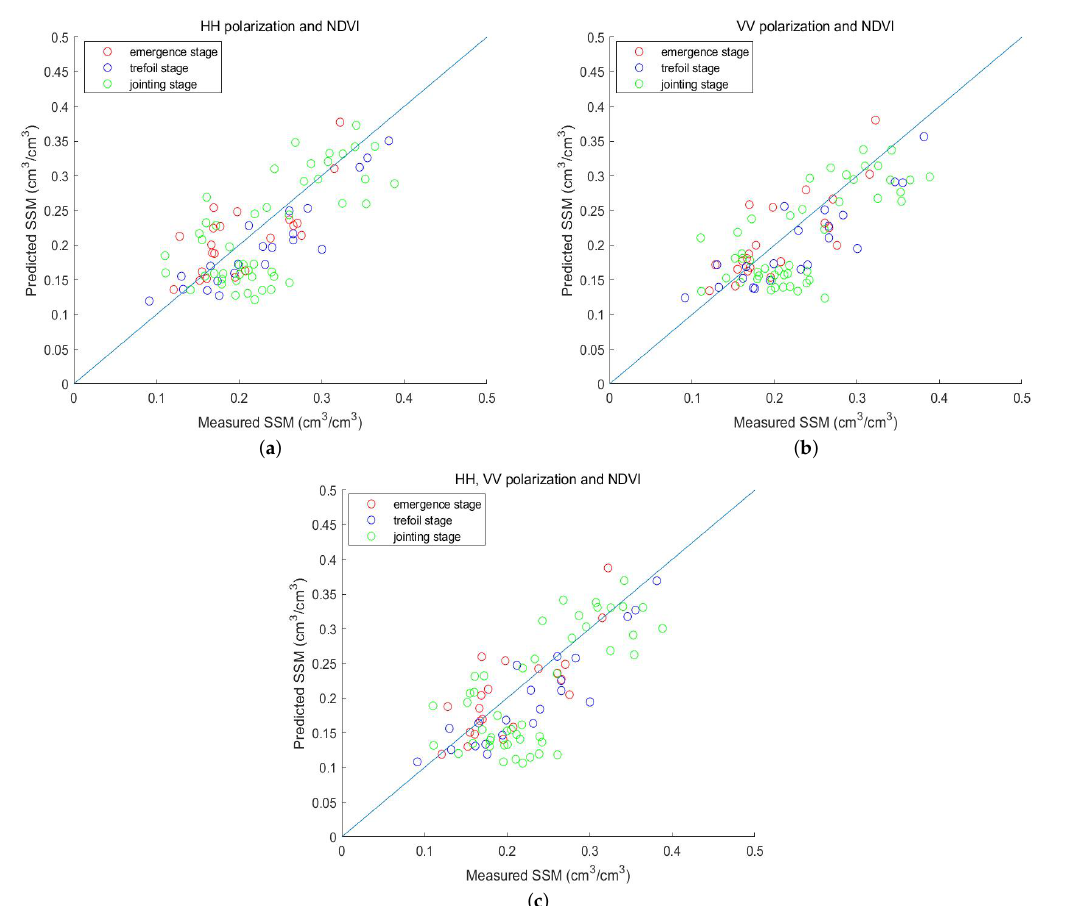
Figure 7. Comparison of the measured SSM with retrieved SSM using three inversion configurations.